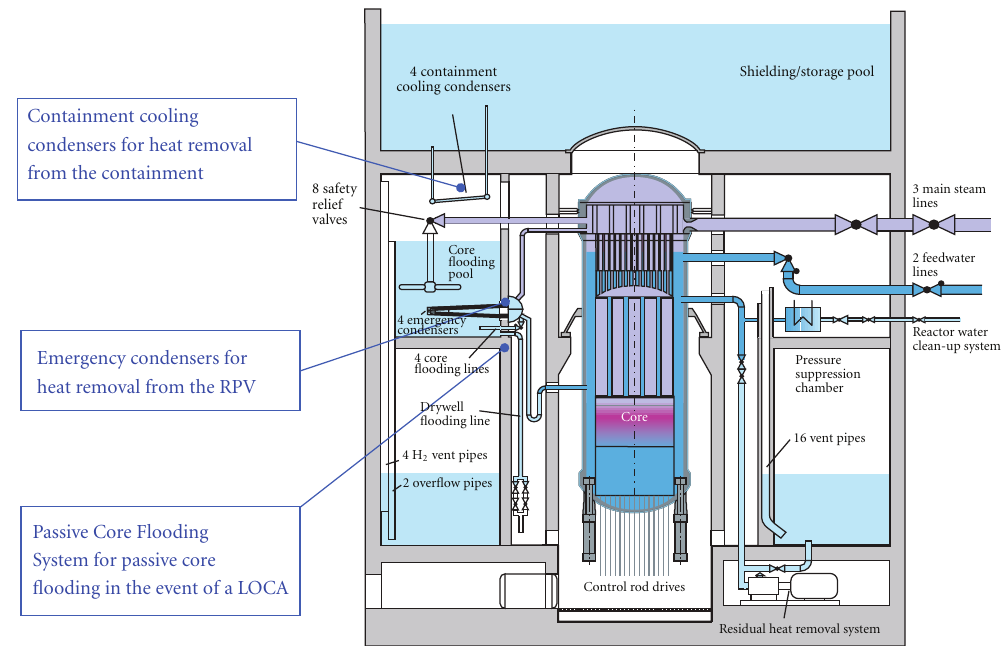
Figure 1: Section through KERENA containment with passive safety systems to be tested at INKA. (Passive Pressure Pulse Transmitter is shown in Figure 2.)